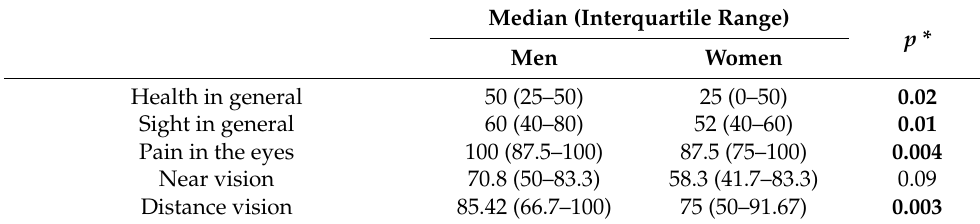
Table 4. Gender differences in visual